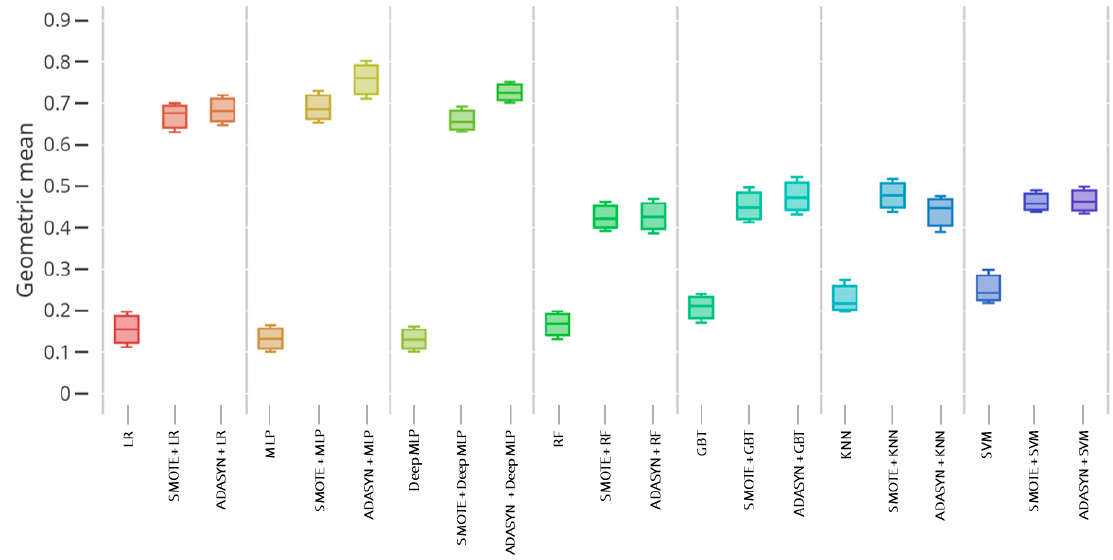
Figure 5. Boxplot of the geometric mean over prediction models among women.